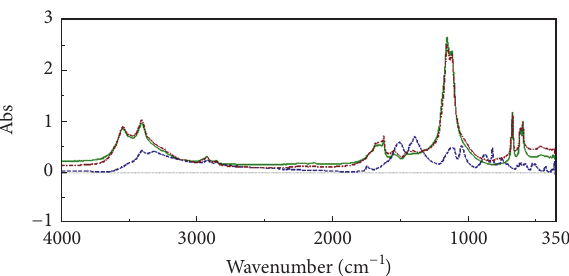
Figure 5: FTIR spectra of green two painting materials: solid line, IG 5 sample; dashed line, malachite; dash-dot line, IG 6 sample.